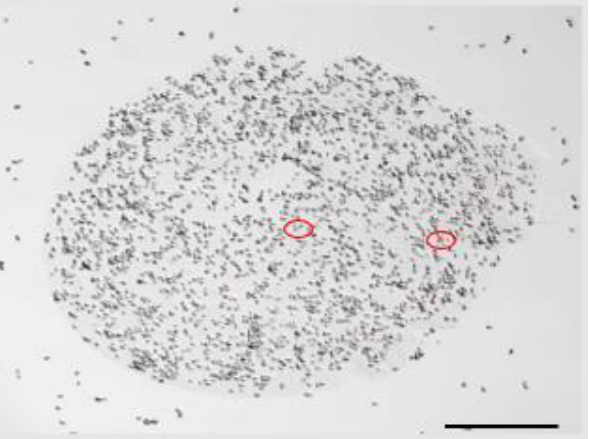
Figure 4. Confocal laser scanning microscopy image of SBWP/AX+ S. boulardii stained with propidium iodide. Circled in red two non-viable cells of S. boulardii . 10× magnification applying a monoparametric detection.